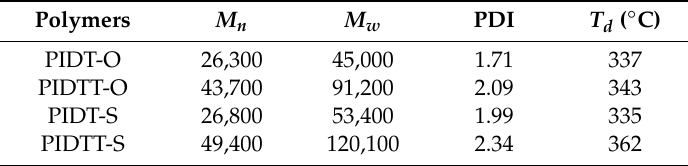
Table 1. Molecular weights and thermal properties for the